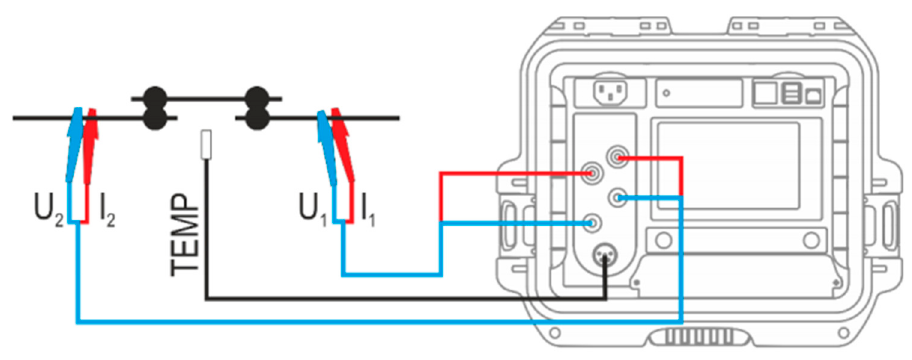
Figure 6. A sketch presenting the connection of brushes to the Sonel MMR-650 device.